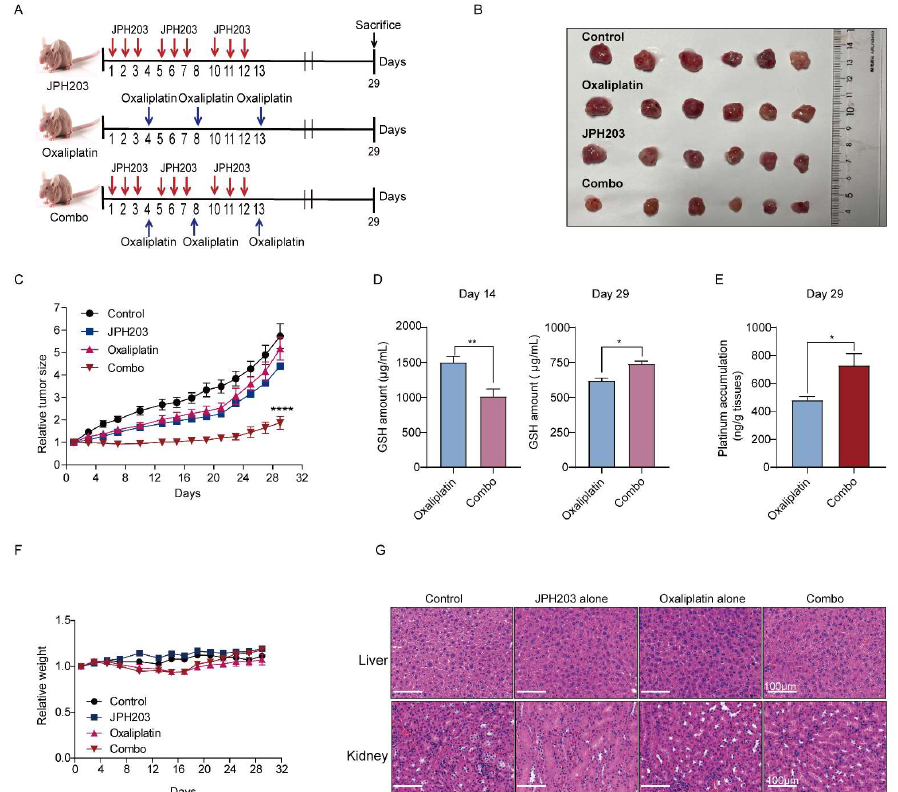
Figure 5. The combination of oxaliplatin and JPH203 enhance the therapeutic effect of RCC tumors. ( A ) The timeline of drug administration. ( B ) Representative photo of the tumors was stripped from sacrificed mice. ( C ) Relative tumor growth of mice bearing drug administration (either single drug or in combination). ( D ) The amount of GSH was detected in tumor of mice bearing with oxaliplatin with and without JPH203 at day 14 and day 29, respectively. ( E ) ICP-MS was used to detect platinum accumulation in tumor tissues from mice treated with oxaliplatin with and without JPH203 at day 29. ( F ) The curves of weight in mice bearing different treatment. ( G ) The hematoxylin–eosin staining was used to evaluate for toxicity of livers and kidneys in mice bearing different drug treatments. Scale bar = 100 µm. Combo—JPH203 in combination with oxaliplatin. Data represent the mean ± SEM. Students t-test (two-tailed) and one-way ANOVA analysis were used. * p < 0.05; ** p < 0.01; **** p < 0.0001.